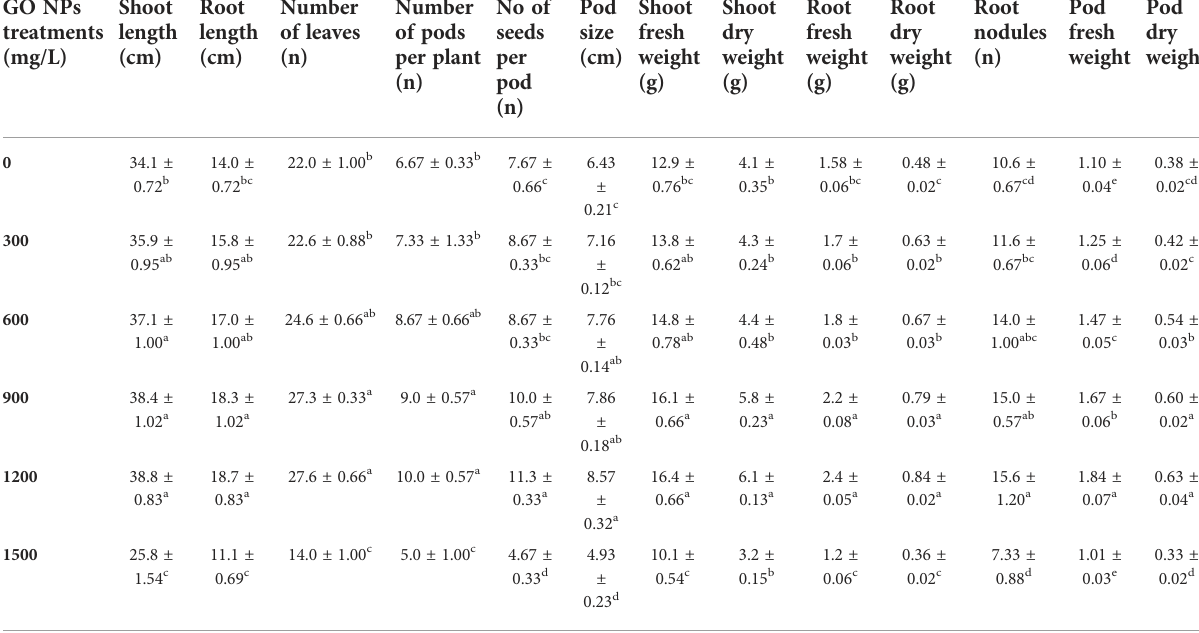
Data represent the mean ± standard error. Different letters denote statistically signi fi cant differences between treatments as evaluated by the Tukey ’ s Multiple range test at the P<0.05 level. C= without GO NPs application (control); T1= 300 mg/L; T2= 600 mg/L; T3= 900 mg/L; T4= 1200 mg/L; T5= 1500 mg/L.